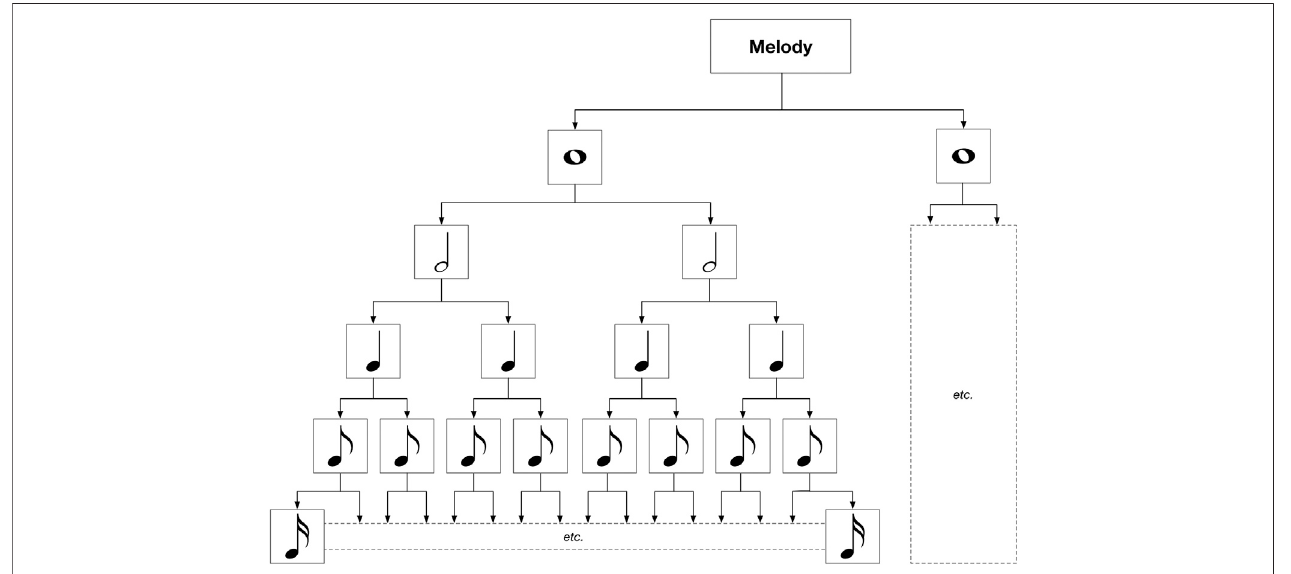
FIGURE2| Thedurationhierarchytypicallyusedbytreestructureswhicharedesignedtorepresentmelodiesincommontime.Thebottomrowofsemiquavershas been truncated for space, and the right-hand side of the tree is not shown to completion as it is identical to the left.